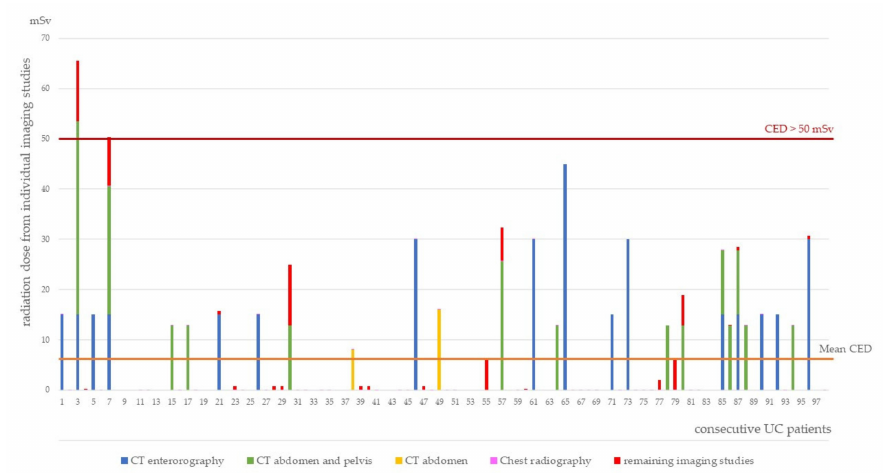
Figure 3. Cumulative effective dose in patients with ulcerative colitis.